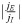
Distribution of inputs from binary neurons for different noise levels.Probability distribution of synaptic input hi = ∑j
Jijnj + ξi of a neuron in a network of independently active cells nj with 〈nE〉 = 〈nI〉 = 0.2 and synaptic weights jI = −0.21, jE = 0.01. |jEjI| was deliberately chosen to be large because only then the convolution of a binomial distribution “squeezed” to the step size jE with the binomial distribution squeezed to the step size |jI| results in a probability distribution with many local maxima leading to the impression of an oscillation. The noiseless case ξi = 0 is shown as black dots. The solid black curve indicates the Gaussian approximation (cf. e.g. Eq (16), here without perturbation) of this distribution from the main text. This distribution appears in the expectation values of the activation function F (cf. e.g. Eq (1)): It is a Gaussian distribution with the mean μ = KE
jE
mE + KIjI
mI and the variance σnetwork2=KEjE2mE (1−mE)+KIjI2mI (1−mI) of the original binomial distributions Binom(mE, KE), Binom(mI, KI). The other curves indicate convolutions with the Gaussian noise ξ∼N(0,σnoise) of different magnitudes σnoise, given in units of the noise level σnetwork intrinsically produced by the network.